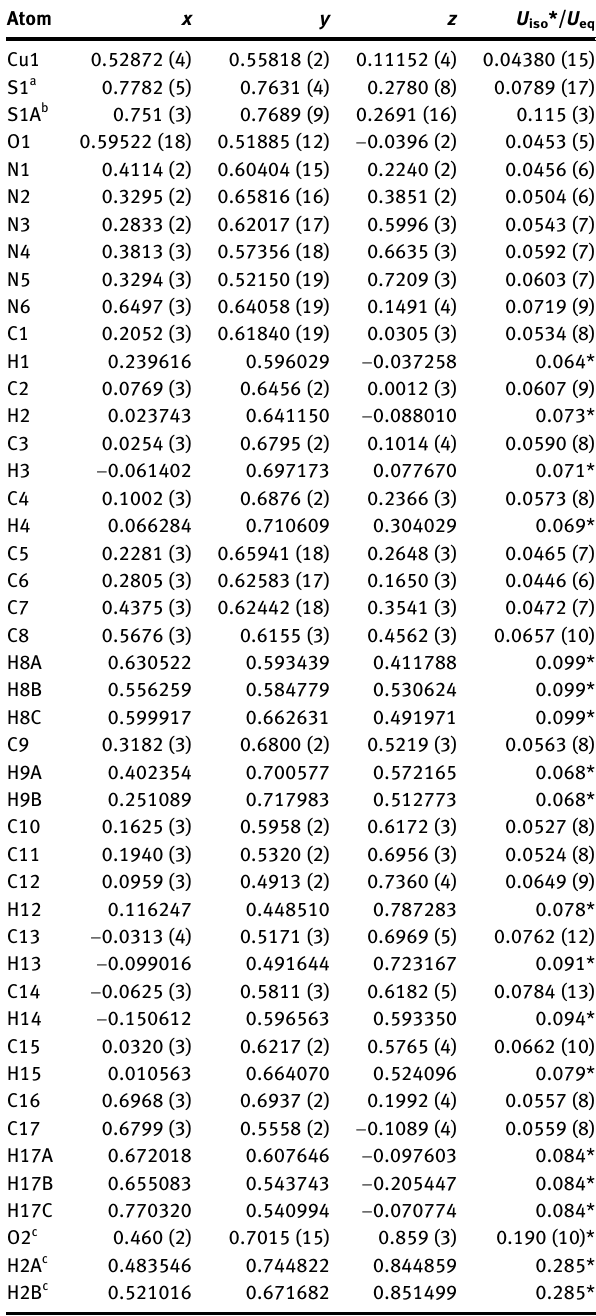
Table  : Fractional atomic coordinates and isotropic or equivalent isotropic displacement parameters (Å 